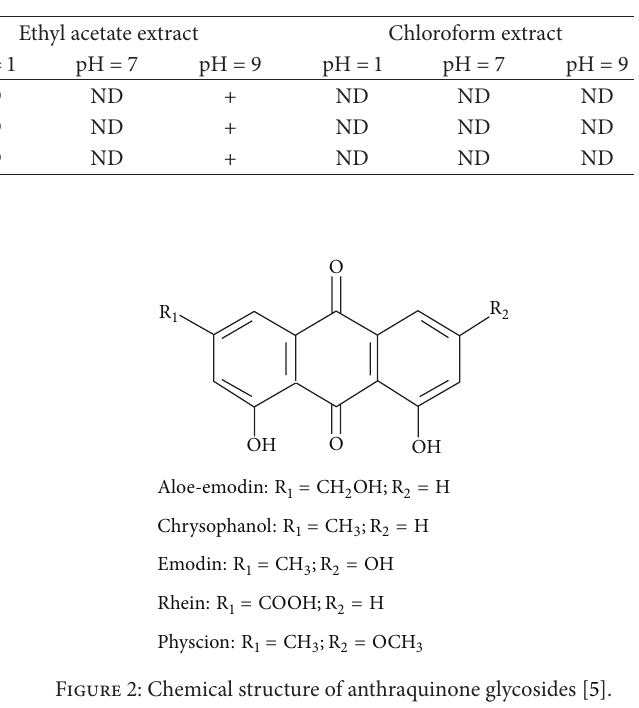
Table 2: Qualitative screening by gas chromatography-mass spectrometry (GC-MS).